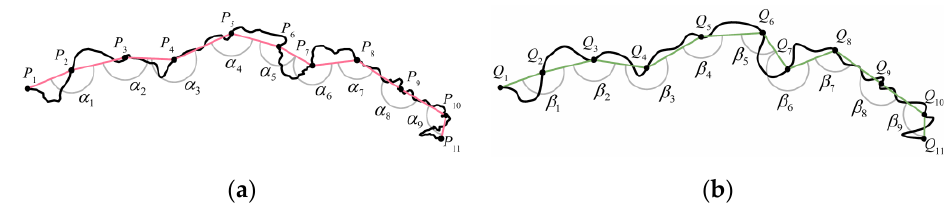
Figure 3. Curve shape feature extraction: ( a ) curve P ; and ( b ) curve Q